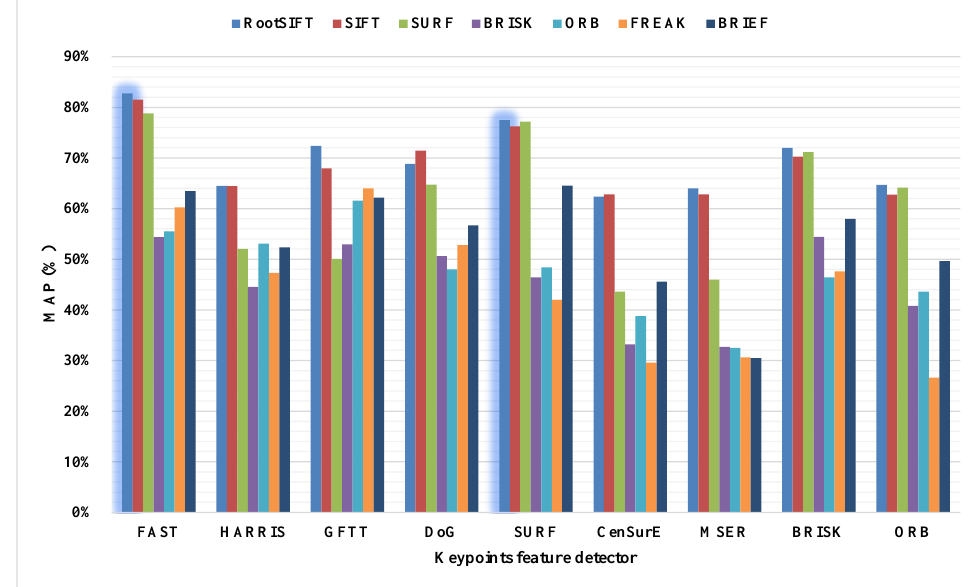
Figure 4. Performance of each keypoint detector with each